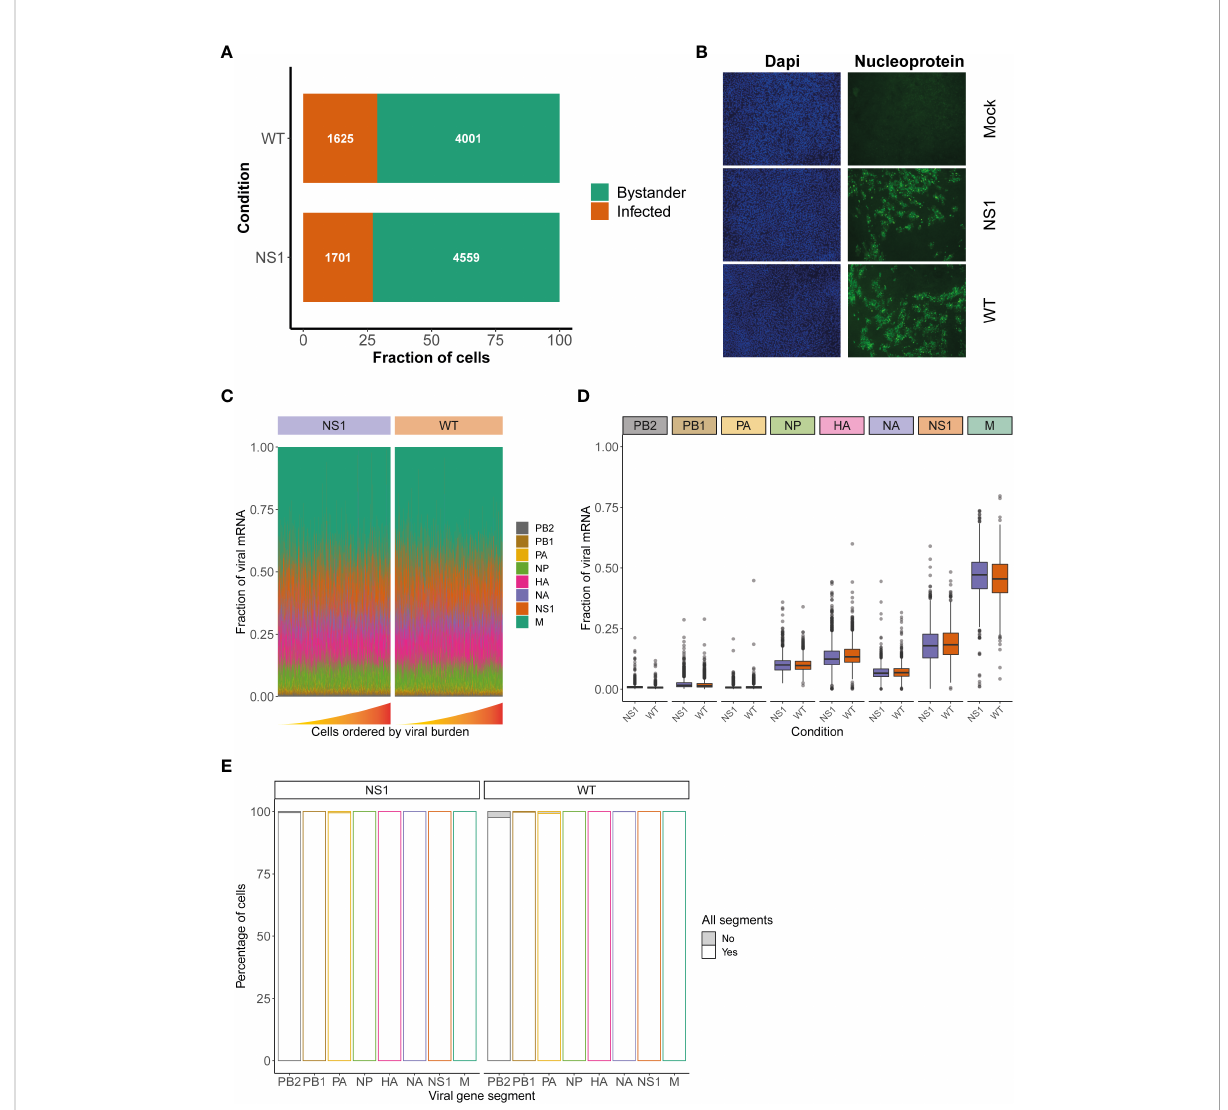
FIGURE 2 Assessment of viral characteristics in WT and NS1 R38A virus-infected cells. (A) Bar graph illustrating the fraction of infected (orange) and bystander (green) cells present in WT and NS1 R38A virus-infected hAEC cultures. (B) Immuno fl uorescence images showing mock, WT, and NS1 R38A virus-infected hAEC cultures stained with DAPI (nuclei in blue; panel on left) and for the viral nucleoprotein antigen (nucleoprotein shown in green; panel on right). Representative images for each condition are shown at 18 hpi. (C) Relative fraction of expression of viral mRNA per cell in WT and NS1 R38A conditions for each IAV gene segment (only infected cells are included). Cells are ordered by increasing viral burden (from left to right) along the x-axis. (D) Box plot summarizing the relative fraction of viral mRNA for each IAV gene segment for WT (orange) and NS1 R38A (purple) conditions. (E) Bar plot showing the percentage of infected cells expressing each of the 8 viral gene segments for WT and NS1 R38A conditions. The percentage of cells whereby a speci fi c IAV gene segment is present (white) or absent (grey) is shown for each viral gene segment